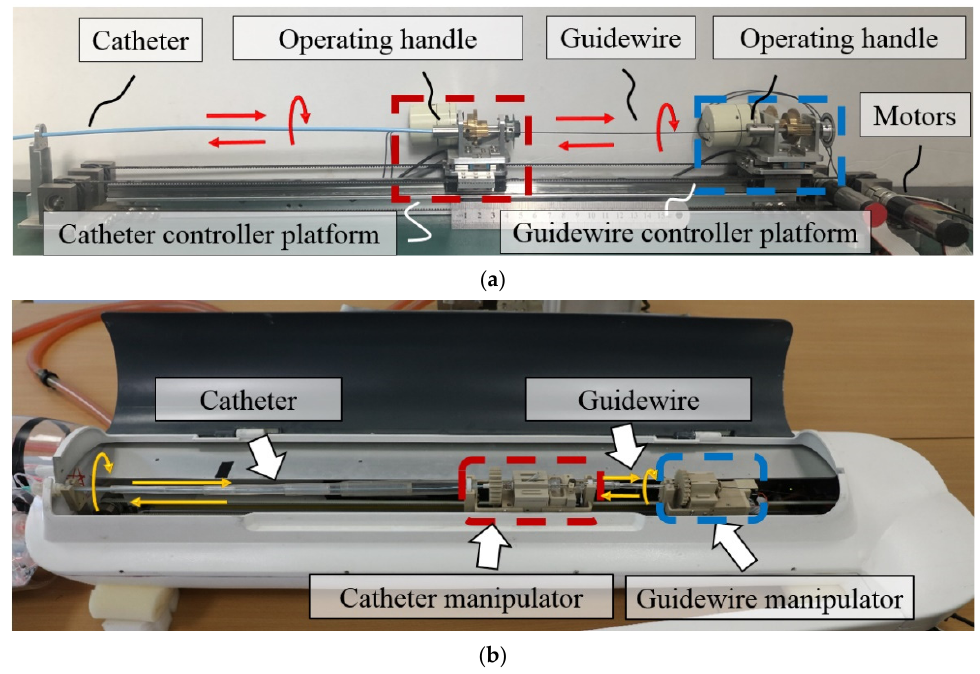
Figure 11. Operational evaluation experiment setup. ( a ) Prototype of the proposed master controller. The main structure of the controller is made of aluminum alloy, and the catheter and guidewire are the same equipment use in actual operation. ( b ) The slave robot being operated at the evaluation experiment. The catheter manipulator was operated by catheter controller platform, the guidewire manipulator was operated by guidewire controller platform.